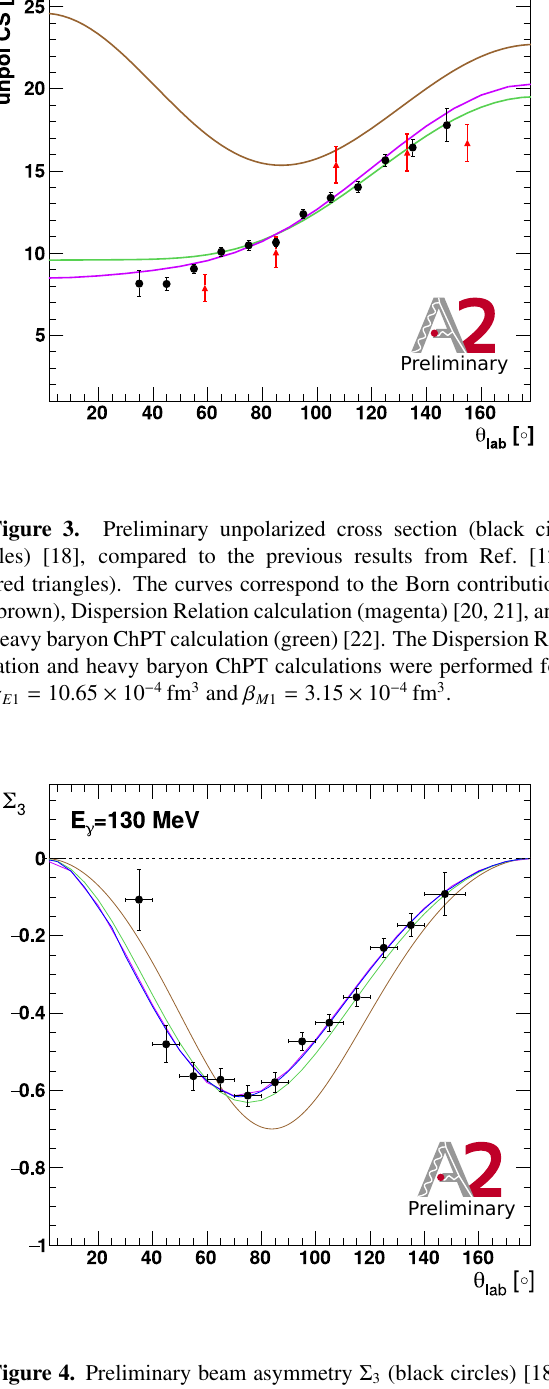
Figure 4. Preliminary beam asymmetry Σ 3 (black circles) [18]. The curves correspond to the Born contribution (brown), Dis- persion Relation calculation (magenta) [20, 21], heavy baryon ChPT calculation (green) [22], and ChPT (blue) [23]. All theo- retical calculations were performed for α E 1 = 10 . 65 × 10 − 4 fm 3 and β M 1 = 3 . 15 × 10 − 4 fm 3